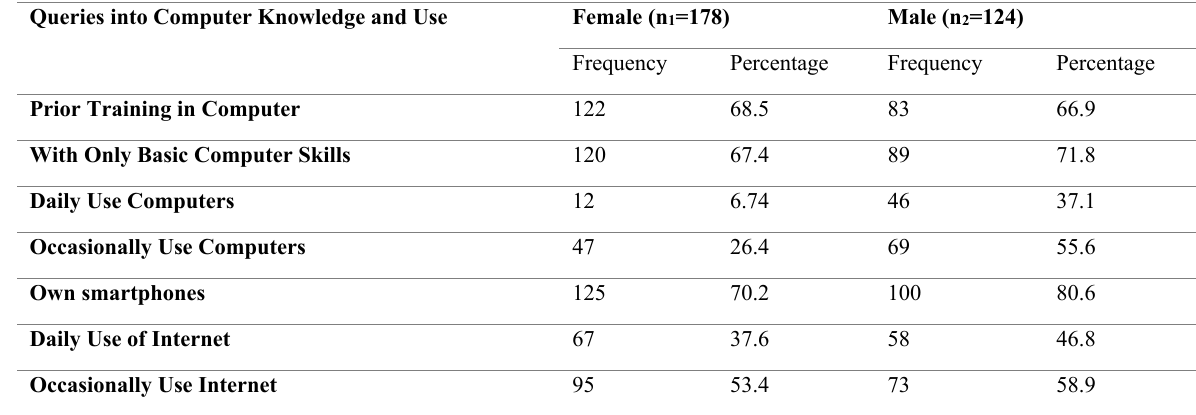
Table 1: Background Knowledge and Access to Digital Technologies